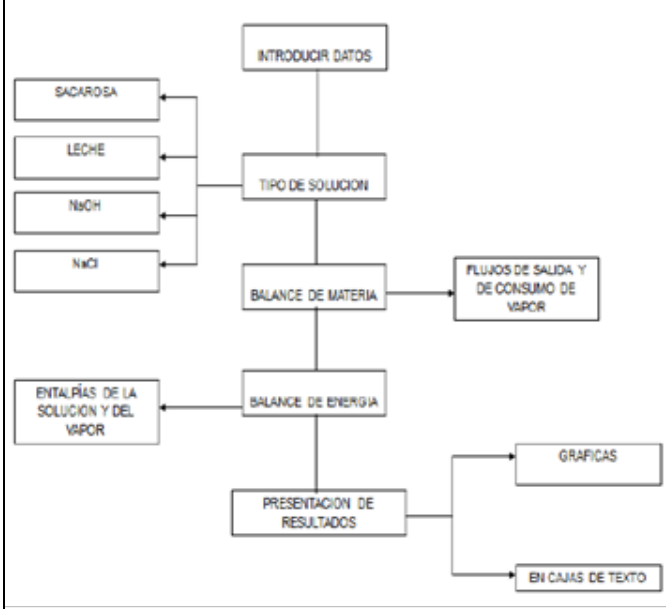
Figura1: Diagrama de flujo de la secuencnia de cáñculo. Fuente: Los autores,